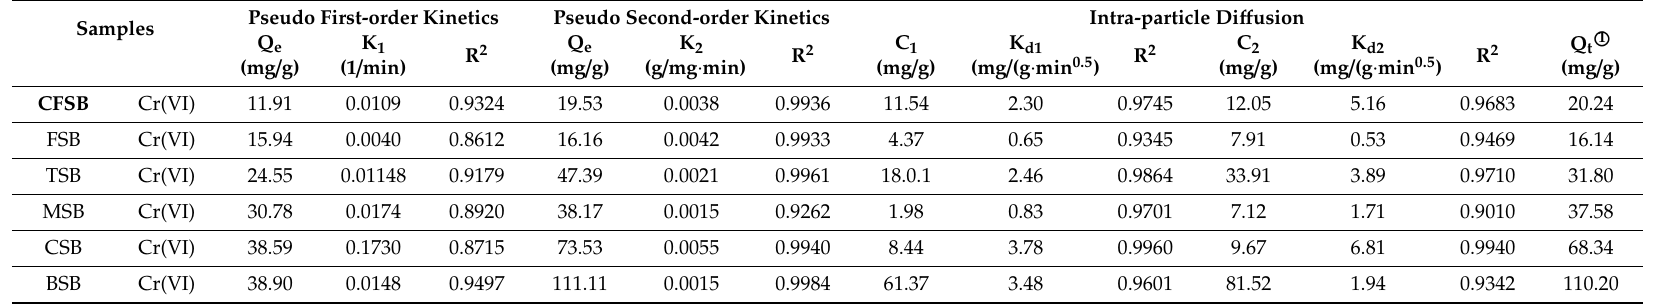
Table 2. Adsorption kinetics parameters for the six types of